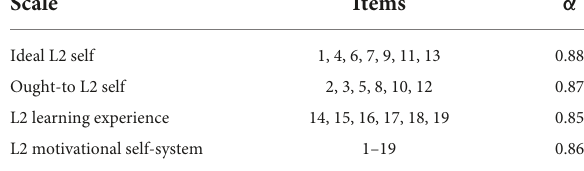
TABLE 2 Reliability analysis of L2 motivational self-system